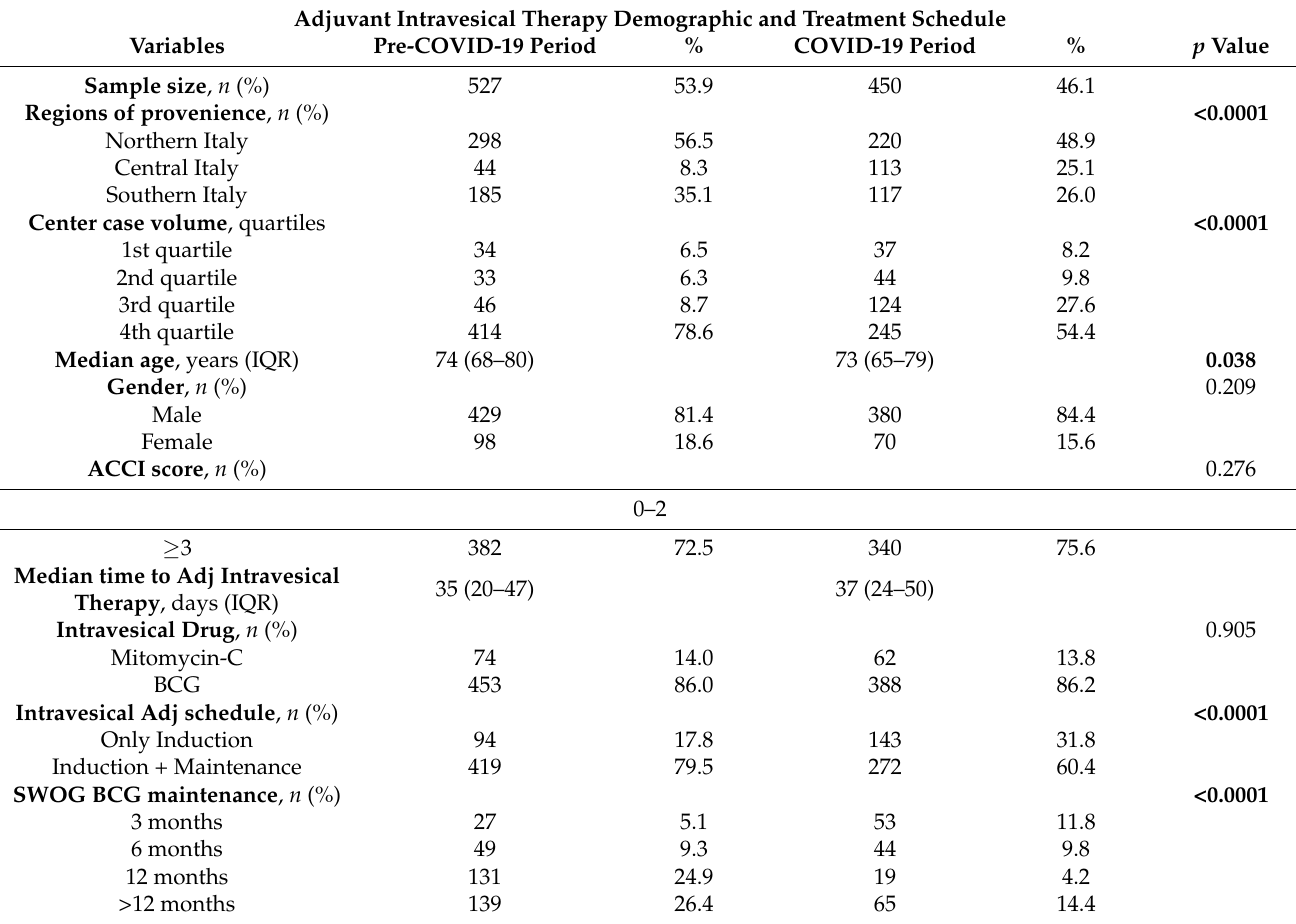
Table 3. Descriptive characteristics of adjuvant intravesical therapy cohort. In bold, value < 0.05.